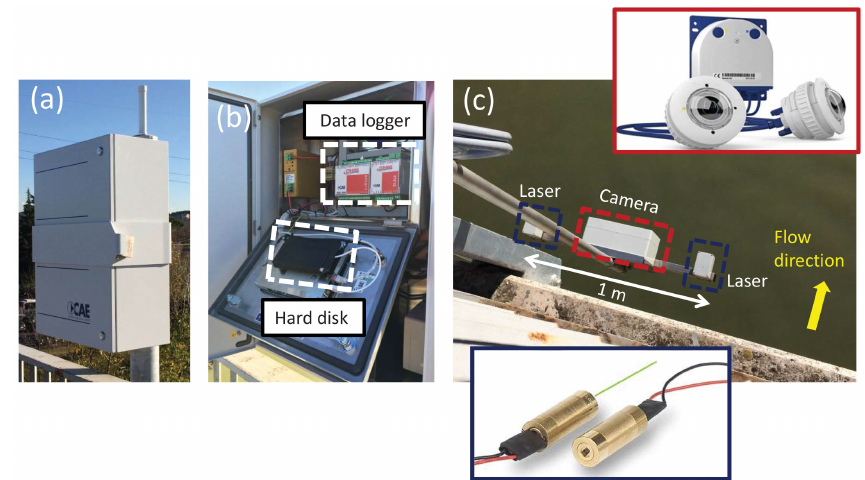
Figure 2. Components of the gauge-cam station including (a) the control unit, (b) data logging terminal, and (c) sensing unit with camera and lasers.